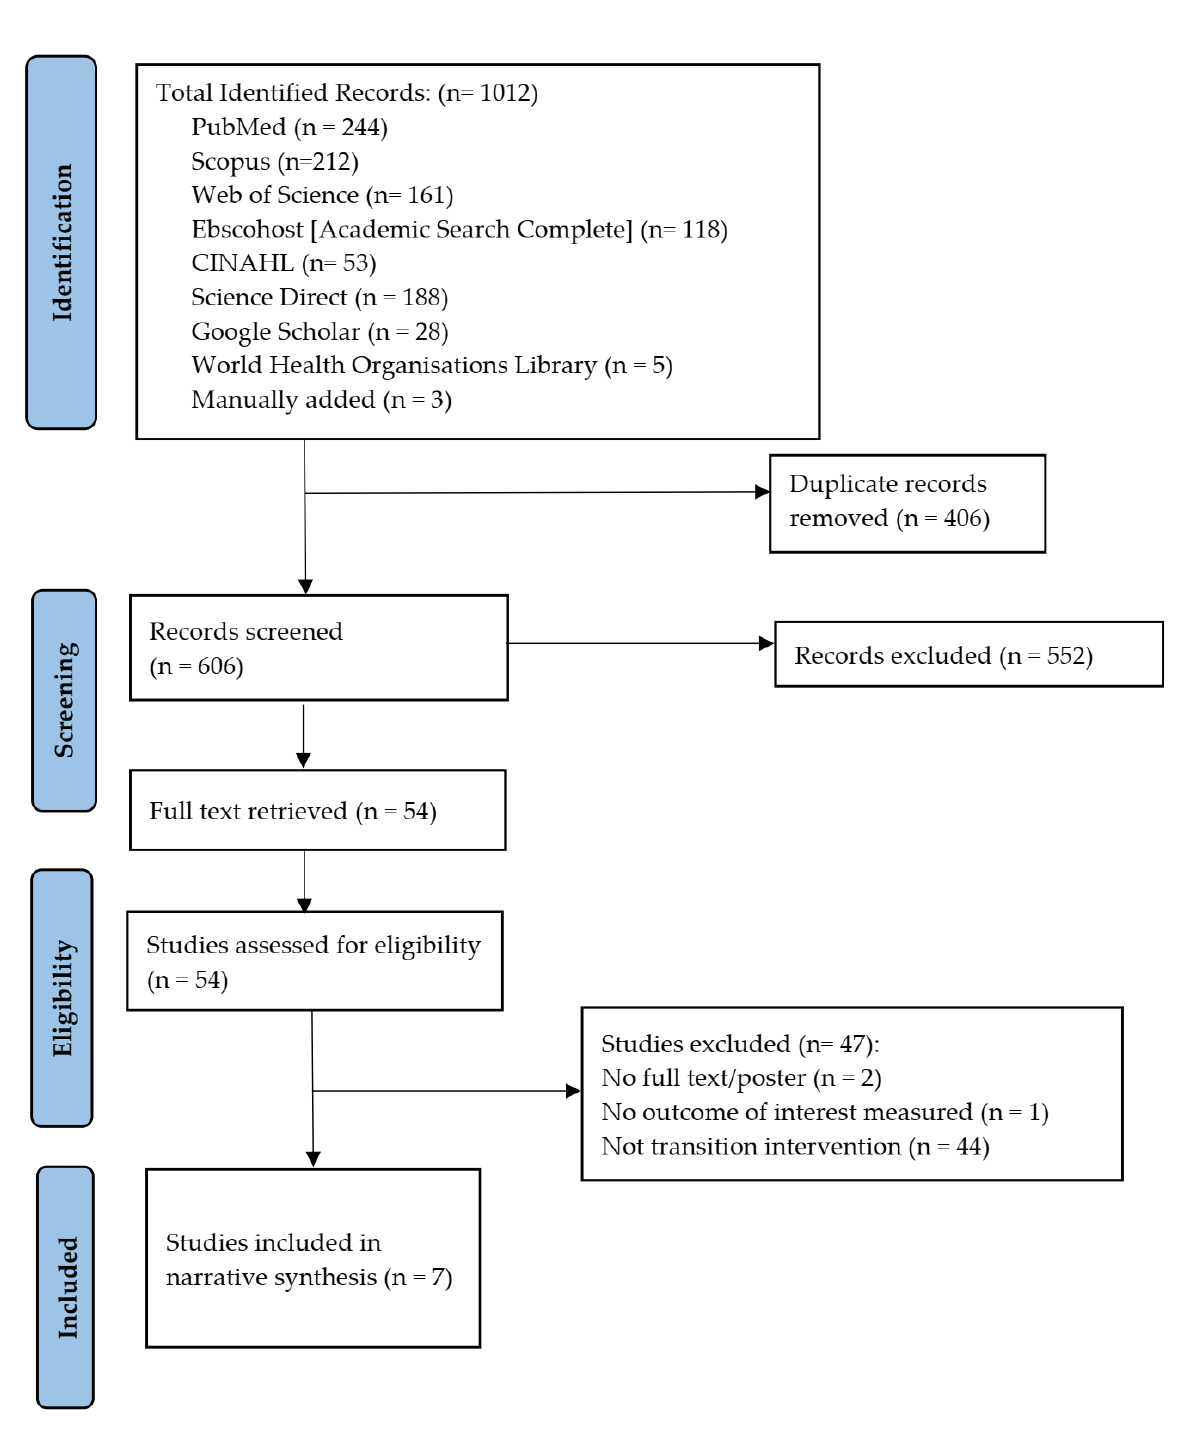
Figure 1. Prisma flow diagram for the review.